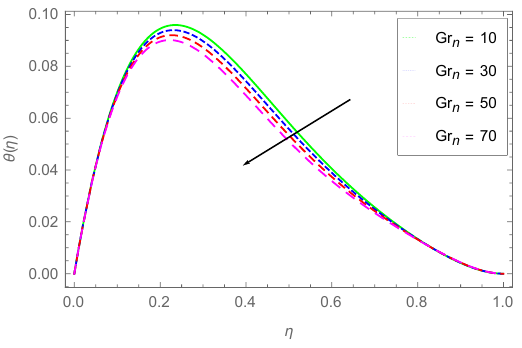
Figure 13. θ ( η ) dependence on Gr